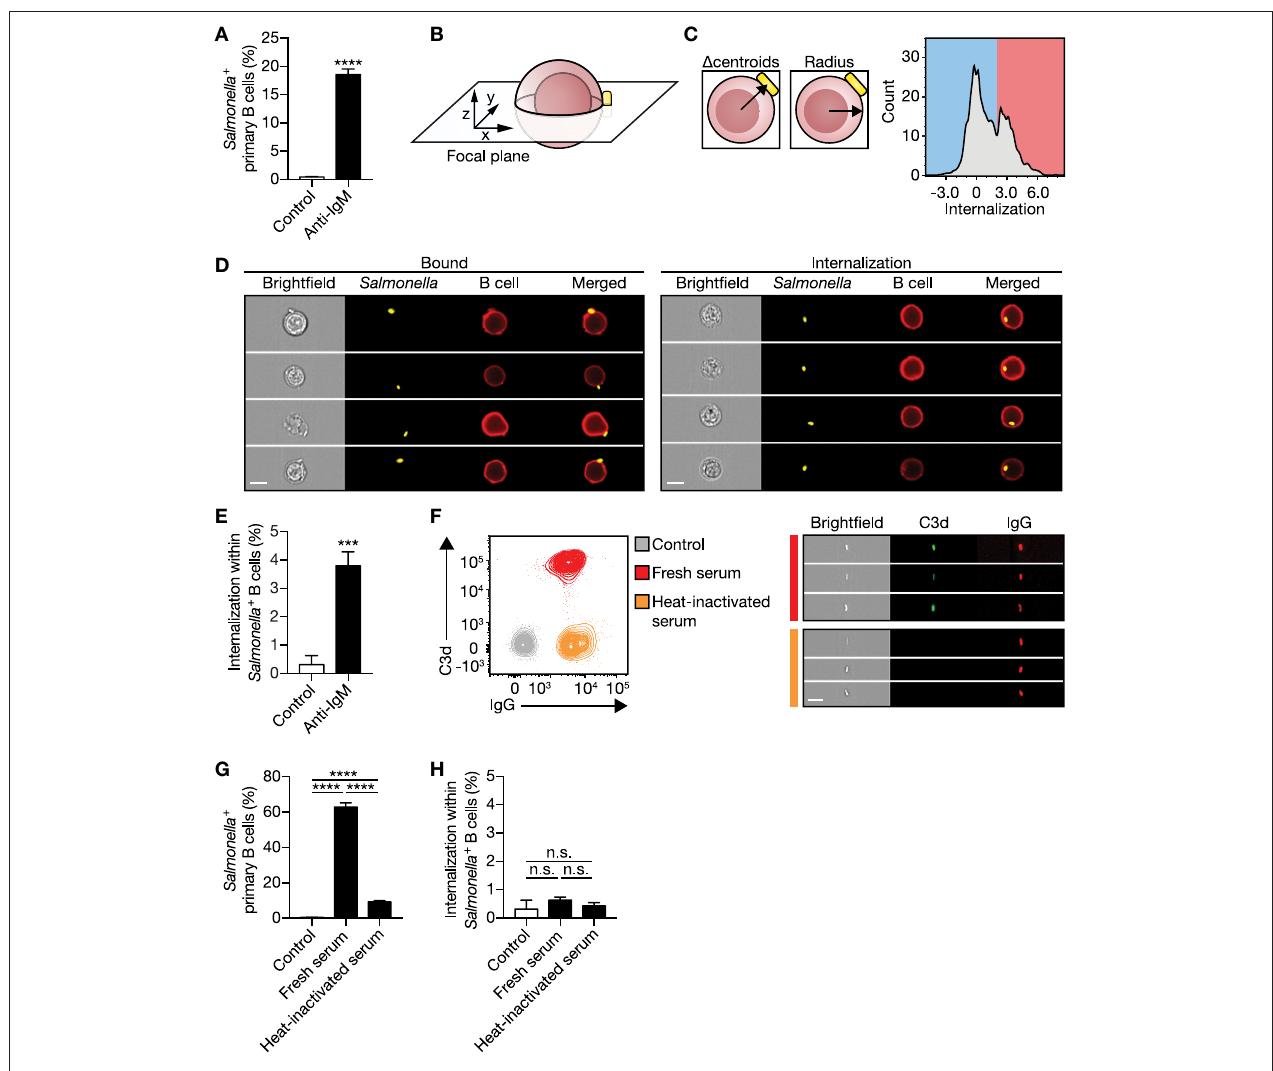
FIGURE 1 | IgM - BCR stimulation specifically promotes large particle internalization. (A) Proportion of primary human B cells interacting with control or anti-IgM-coated S. typhimurium ( n = 9). (B) Schematics of a B cell: S. typhimurium interaction. Internalization was assessed using a high-throughput quantitative image analysis approach for S. typhimurium located in the same focal plane as the human B cell only. (C) To discriminate between bound and internalized S. typhimurium , analysis masks were generated to determine the center of both the B cell and S. typhimurium. Internalization was defined as the distance between the two centroids (left) after correction for the B cell radius as a measure for the cell size (middle). Internalization was plotted against the event count (right). The red/blue shadings behind the plot indicate the portion of cells that bound (blue) or internalized (red) large particles. Events that had a calculated value similar to or > 2 were defined as being internalized. (D) Representative images of primary human B cells containing bound (left) or internalized (right) S. typhimurium . Bar, 7 µ m. (E) Proportion of internalization of control or anti-IgM-coated S. typhimurium within Salmonella + primary human B cells ( n = 9). (F) Representative plots (left) and images (right) of S. typhimurium opsonized with antibodies (IgG) or together with complement (C3d) derived from human serum. Bar, 7 µ m. (G–H) Proportion of primary human B cells that interacted with (G) and internalized (H) serum-opsonized S. typhimurium ( n = 9). Bars depict mean values and error bars are SEM. *** P < 0.001; **** P < 0.0001; n.s., not significantly different by paired t -test (A,E) or repeated-measures one-way ANOVA with Sidak post-test (G,H)